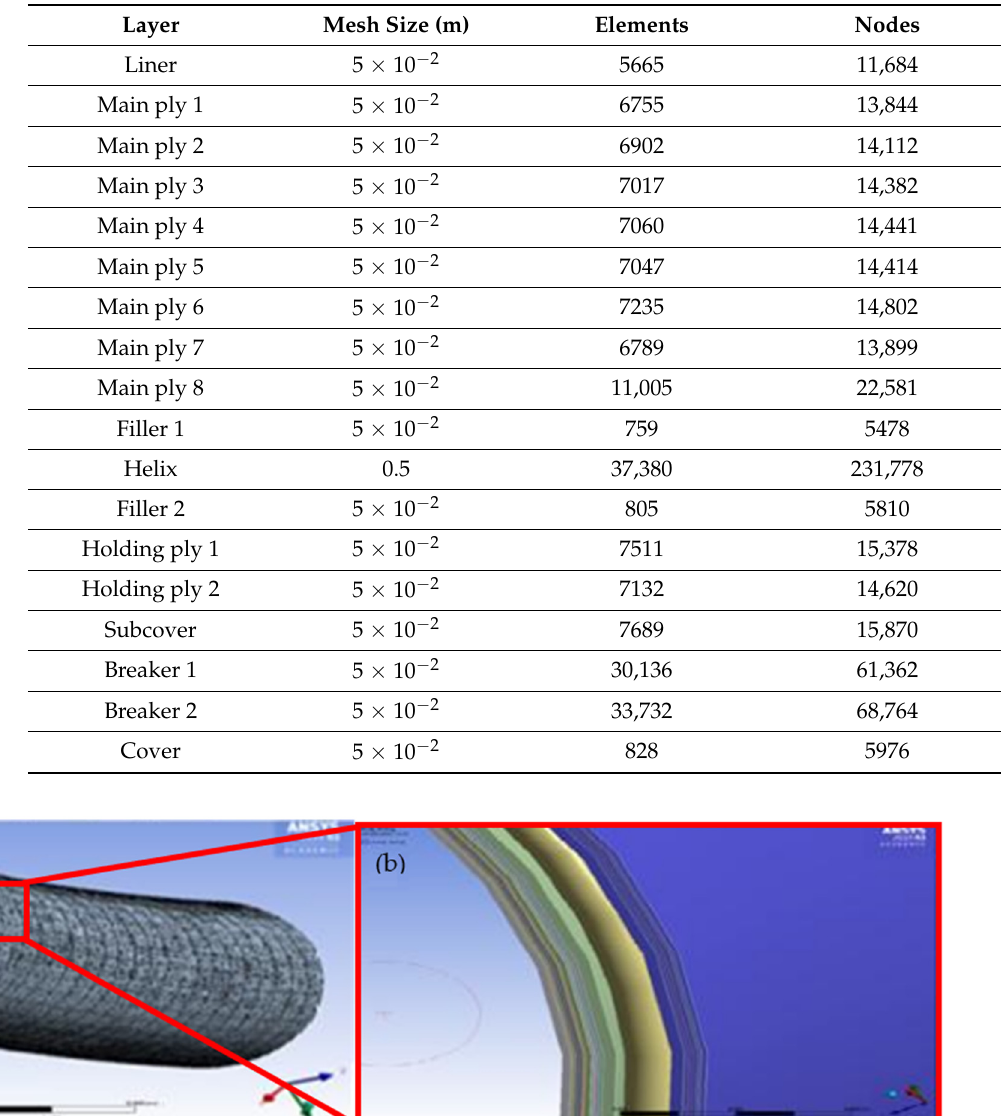
Table 5. Mesh sizing details as applied for each layer of the reeling hose.